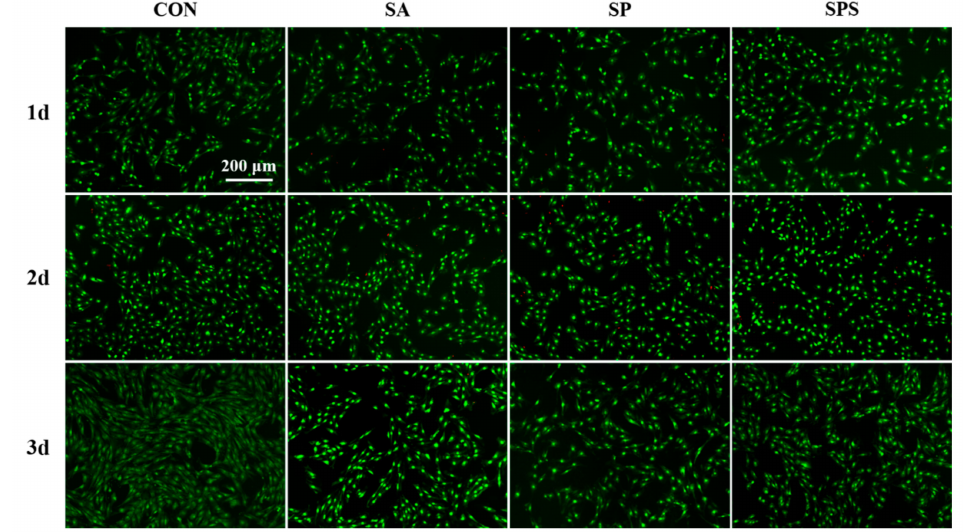
Figure 7. Acridine orange (AO) and propidium iodide (PI) staining images of L929 cell in the SPS, SP, SA and control (CON) groups. (The green dots stained by AO indicate living cells, and the red dots stained by PI indicate dead or dying